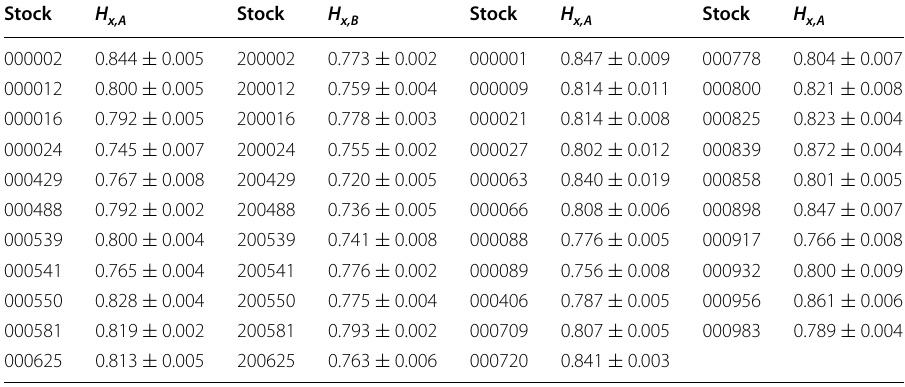
Table 2 Hurst exponents H x of relative prices for the 32 A share stocks and 11 B share stocks estimated using the DMA method